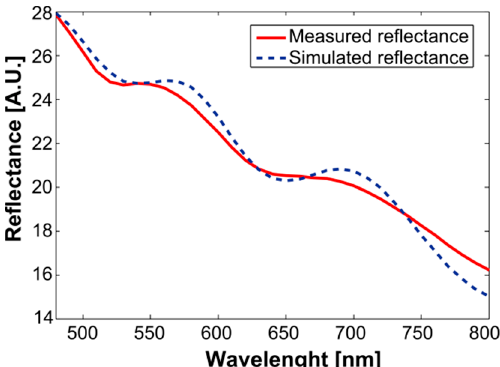
Figure 2. Results obtained from the inverse-modeling procedure. The red line corresponds to the measured diffuse reflectance spectrum ( R m ) of the Si wafer with an evaporated SiO 2 layer, as described in Section 2.1. The blue line presents the corresponding simulated diffuse reflectance spectrum ( R m ) , obtained with the inverse-modeling procedure that is presented in Section 2.3. Table 1. Results of the model’s variables obtained from the inverse-modeling procedure. Thickness of SiO 2